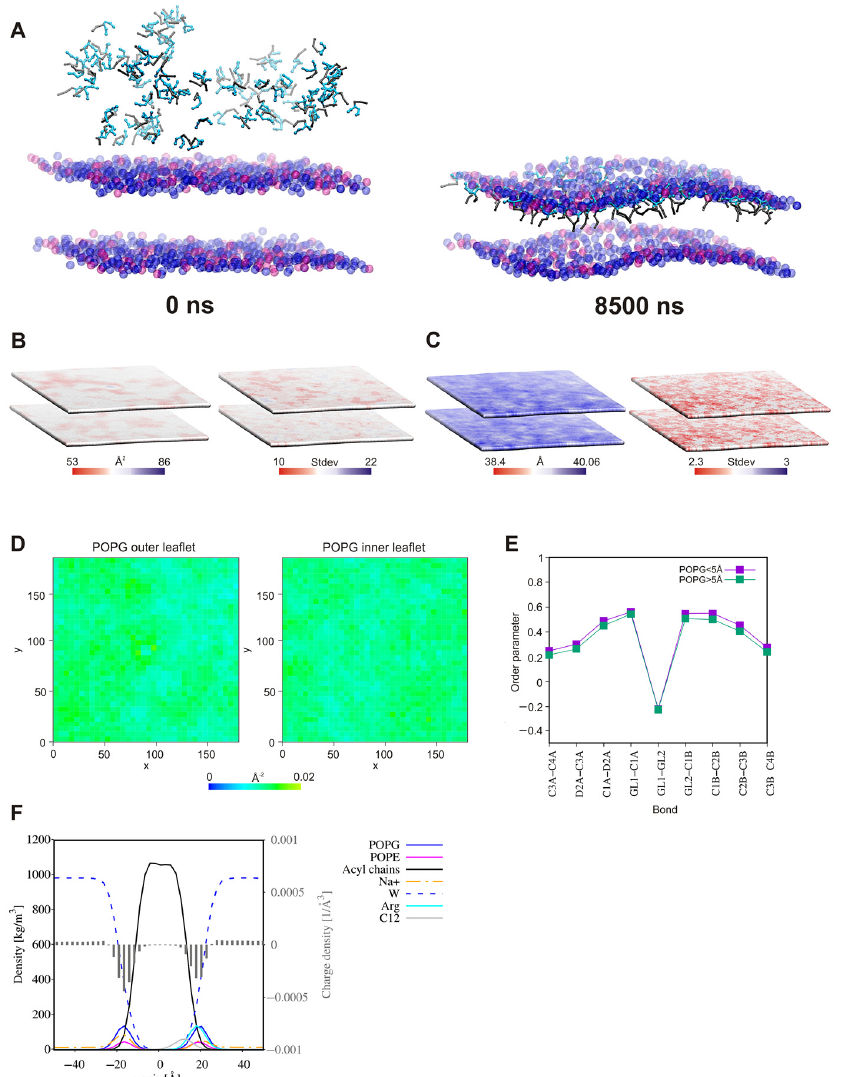
Figure 15. ( A ) Initial and final snapshots from the 3:1 POPG:POPE binding simulations for A3 . Fatty acid tails are in gray, while arginines are in cyan. Lipid tails were omitted for clarity, and only the POPG and POPE phosphate beads are shown in blue and pink, respectively. ( B ) Local area per lipid (APL) and standard deviations of the local membrane APL and ( C ) local thickness of the bilayer. ( D ) 2D density map of the POPG lipids in the outer and inner leaflets of the POPG:POPE membrane (a grid spacing was set to 5 Å). APL, membrane thickness, and 2D density maps were calculated for phosphate beads of the lipid headgroups. ( E ) Lipid acyl chain order parameters of POPG molecules, separately for the lipids at a distance less than and greater than 5 Å from the lipopeptide molecules. ( F ) Partial density and charge density profiles. All the analyses were performed over the last 100 ns of CG MD simulations. POPE: 1-palmitoyl-2-oleoyl-sn-glycero-3-phosphoethanolamine, POPG: 1-palmitoyl-2-oleoyl-sn-glycero-3-phosphoglycerol.